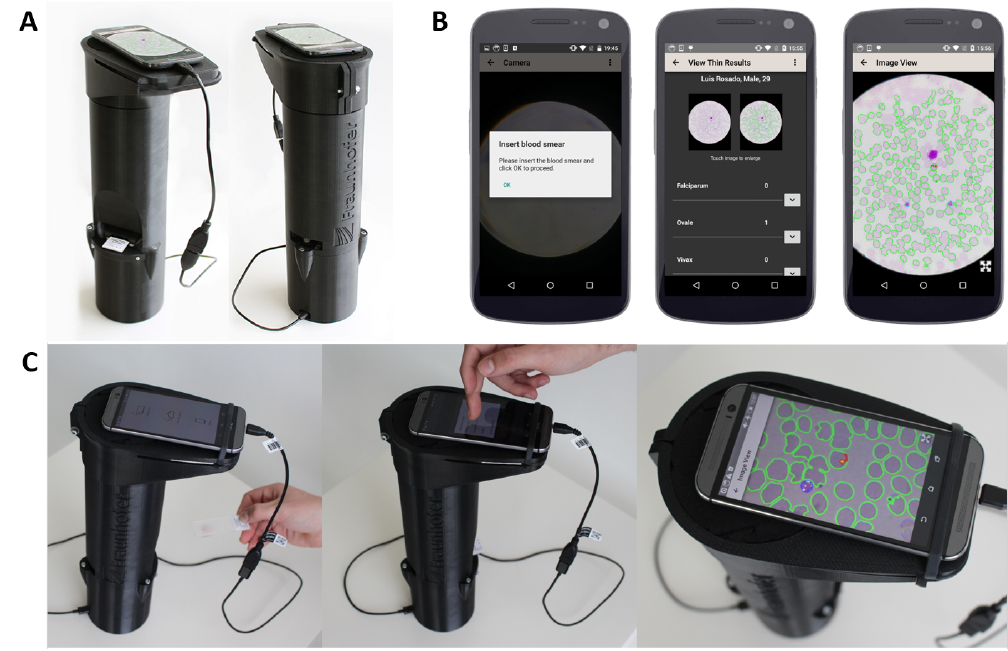
Figure 2. Mobile-based framework for malaria parasites’s detection: ( A ) µ SmartScope with smartphone attached and blood smear inserted; ( B ) smartphone application screenshots; ( C ) exemplificative usage of the solution (from left to right): (i) blood smear insertion; (ii) start image acquisition through the smartphone app; and (iii) visual feedback of the automated